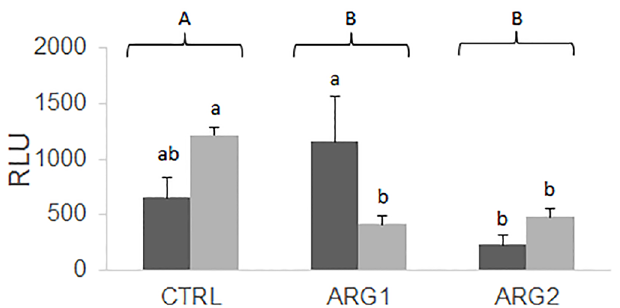
Fig 2. Respiratory burst activity of circulating leucocytes of European sea bass fed different diets for 15 (black columns) or 29 (grey columns) days. Values represent means ± SEM of relative light units (n = 6). Different capital letters stand for statistically significant differences between diets regardless of feeding time. Different low case letters stand for statistically significant differences between diets within the same feeding time (Two-way ANOVA; P <